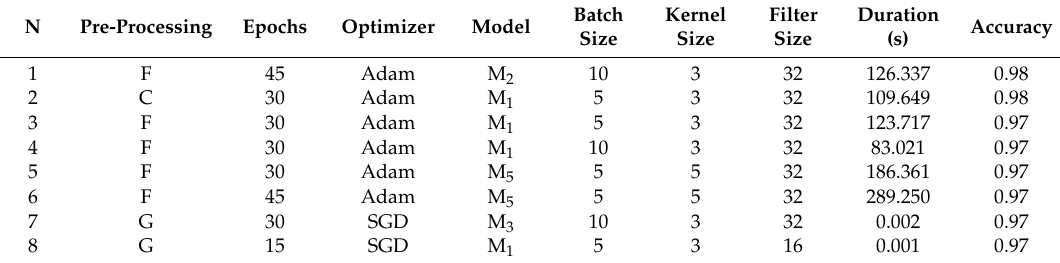
Table 2. Extract of CNN test results without augmentation techniques.